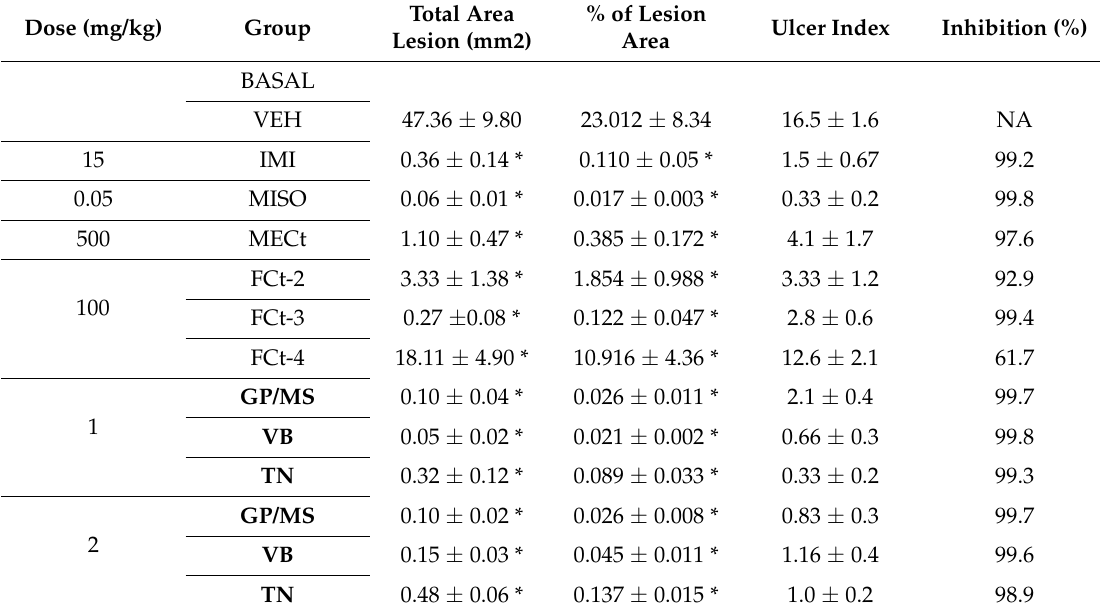
Figure 3. Macroscopic images of representative stomachs after CRS-induced gastric lesions in mice. Panels: (A) Basal; (B) VEH; (C) IMI; (D) MISO; (E) MECt; (F) FCt-2, (G) FCt-3 (H) FCt-4; and compounds at 1 mg/kg (I) GP / MS , (K) VB , (M) TN , and 2 mg/kg (J) GP / MS , (L) VB , (N) TN . Arrows indicate gastric ulcers. Table 2. Effect of treatments of Castilleja tenuiflora Benth. on mucosal lesions in the cold-restraint stress